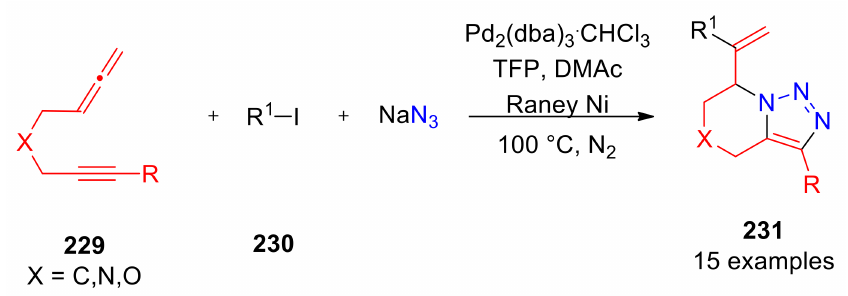
Scheme 73. Palladium-catalyzed three-component reaction using different organic